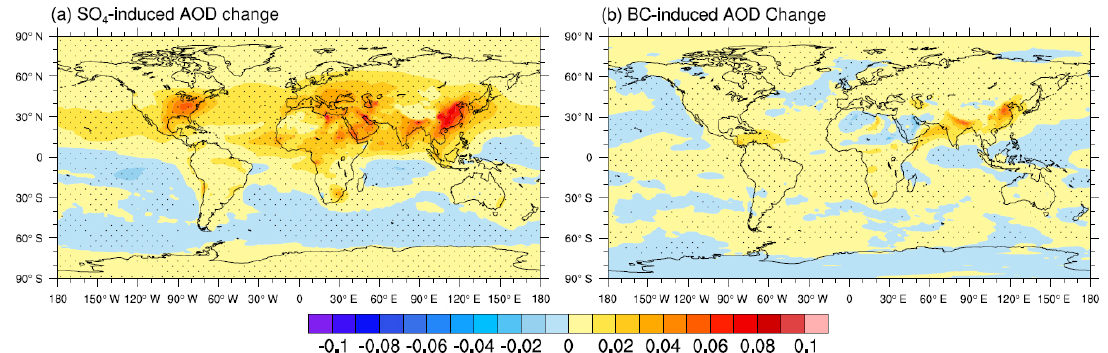
Figure 1. Annual mean distributions of changes in aerosol optical depths at 550nm from PI to PD induced by (a) SO 4 and (b) BC. The dots represent significance at ≥ 95% confidence level from the t test.